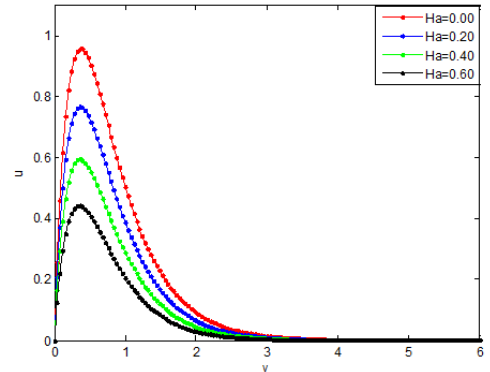
Figure 17. Effects of Hartmann number on the velocity distribution